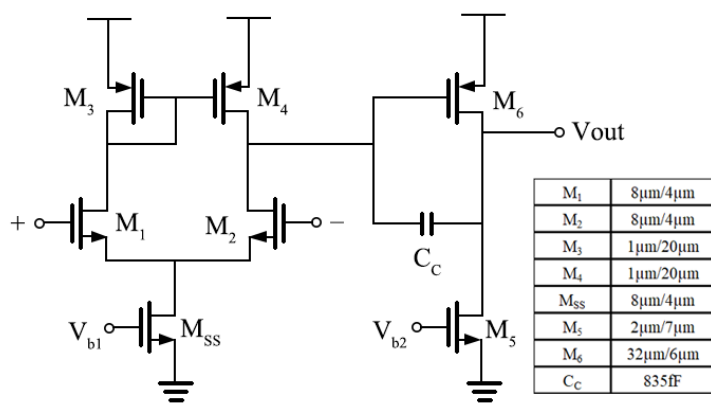
Figure 3 . The schematic of OTA 1 . Figure 3. The schematic of OTA 1 .